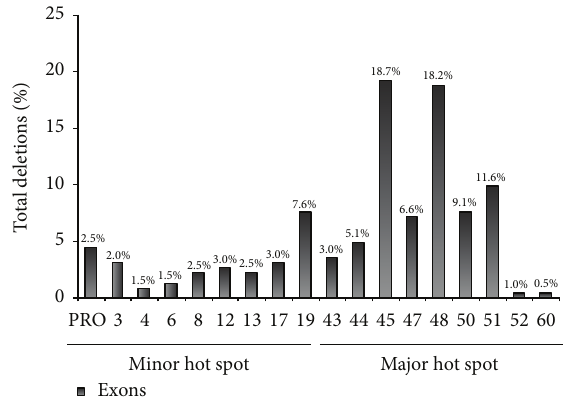
Figure 1: Distribution of the mutations detected in the DMD gene in patients with Duchenne muscular dystrophy/Becker muscular dystrophy